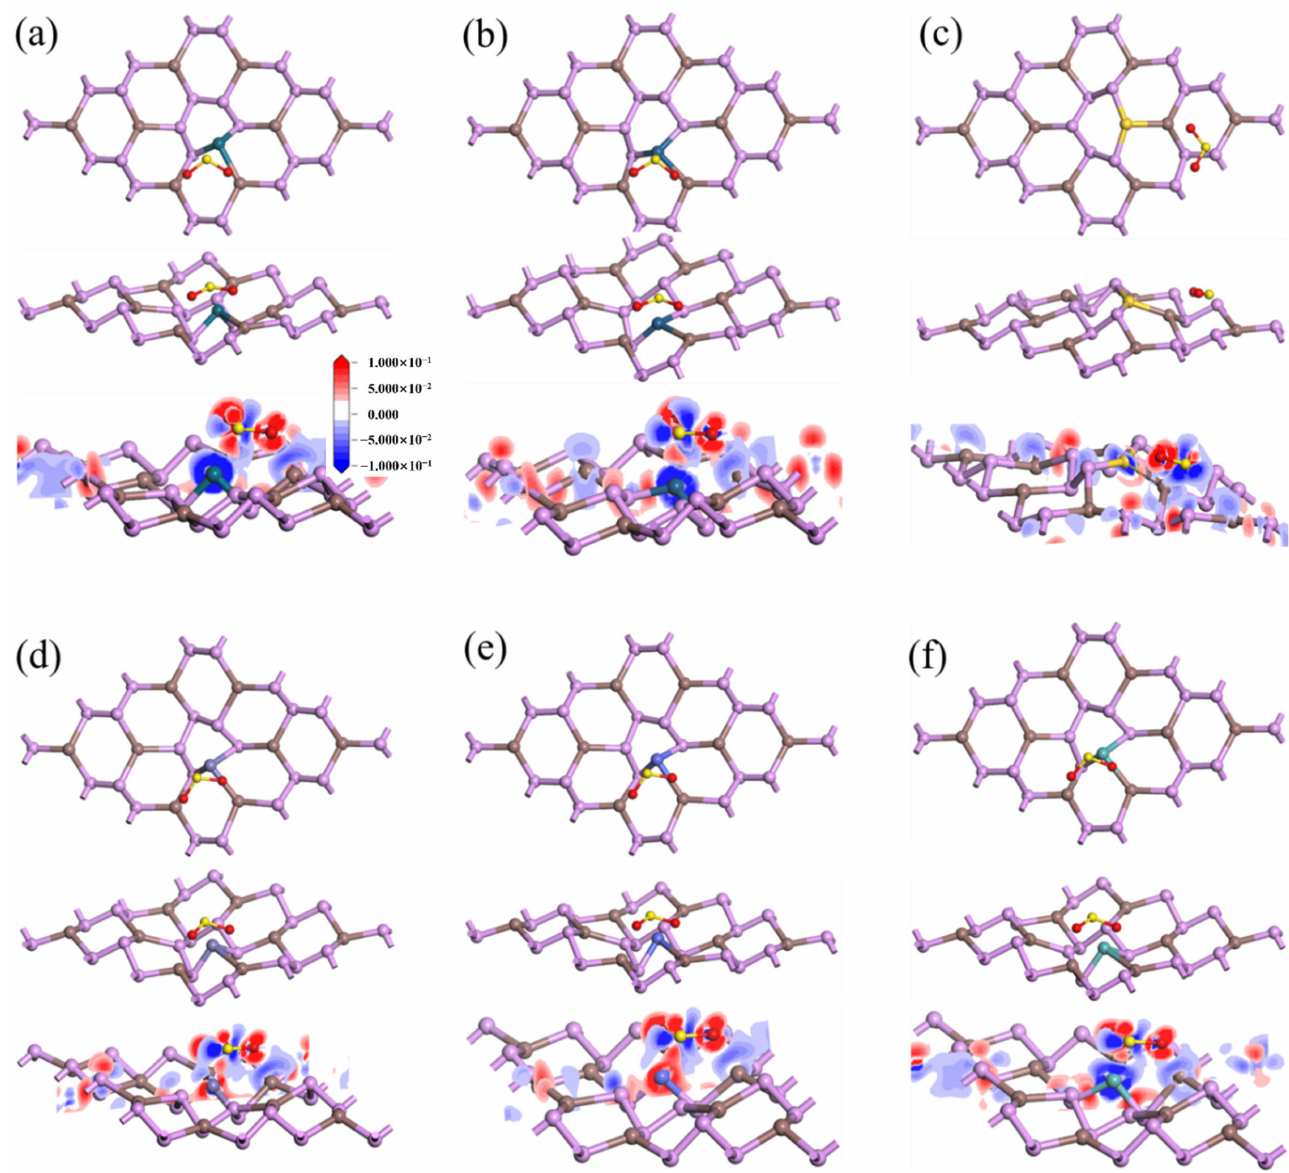
Figure 4. Adsorptive structure and DCD of ( a ) Pd-InP 3 /SO 2 , ( b ) Pt-InP 3 /SO 2 , ( c ) Au-InP 3 /SO 2 , ( d ) Fe-InP 3 /SO 2 , ( e ) Co-InP 3 /SO 2 and ( f ) Mo-InP 3 /SO 2 . Next, the interactions between SO 2 and TM-InP 3 monolayers were further verified by DCD. In Pd-InP 3 , Pt-InP 3 and Mo-InP 3 adsorption systems, the electron depletion regions are mainly concentrated on TM-doped atoms, while in Fe-InP 3 and Co-InP 3 adsorption systems, the electron aggregation areas are around TM dopants. From the DCD diagrams of the above five systems, we can see that there is a pronounced overlap between